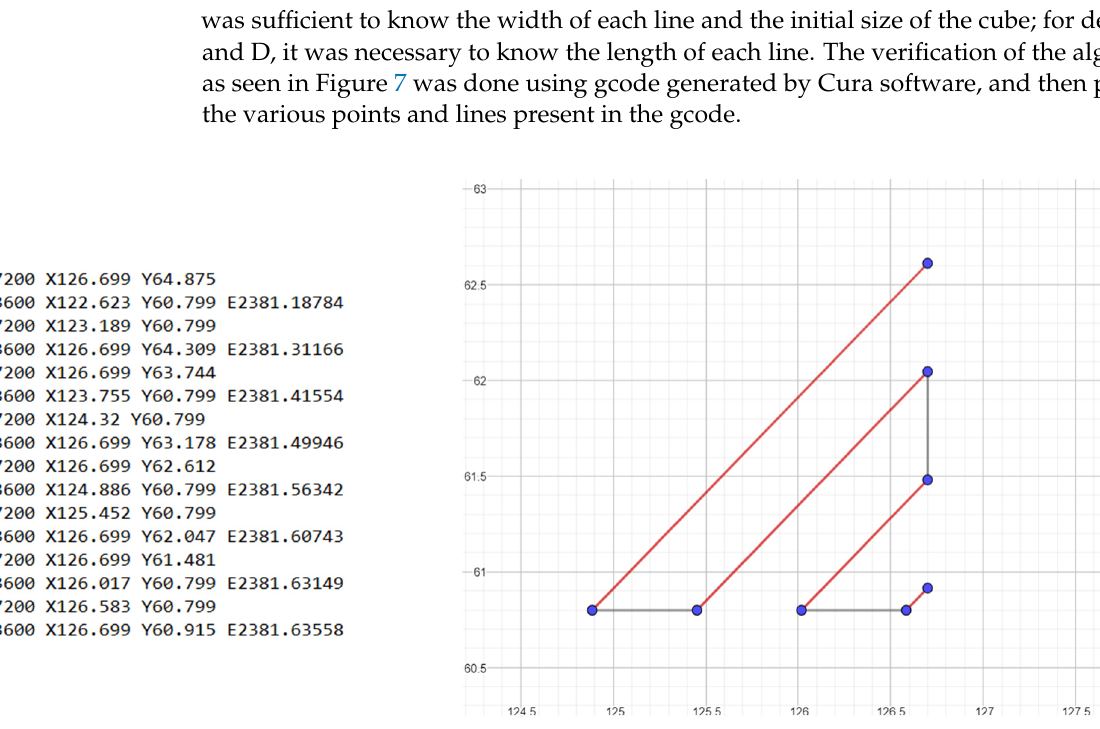
Figure 7. Example of a printing gcode ( left ); last 8 lines of gcode drawn in geogebra ( right ); in red: the extrusion moving path, in gray: the shift movement of a single printer head.